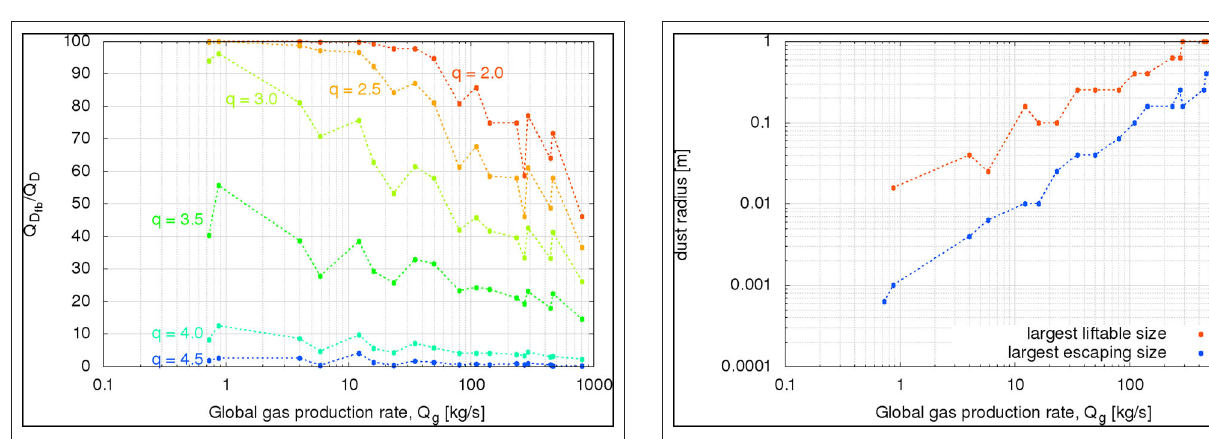
to escape the gravity field of the comet and will be redeposited